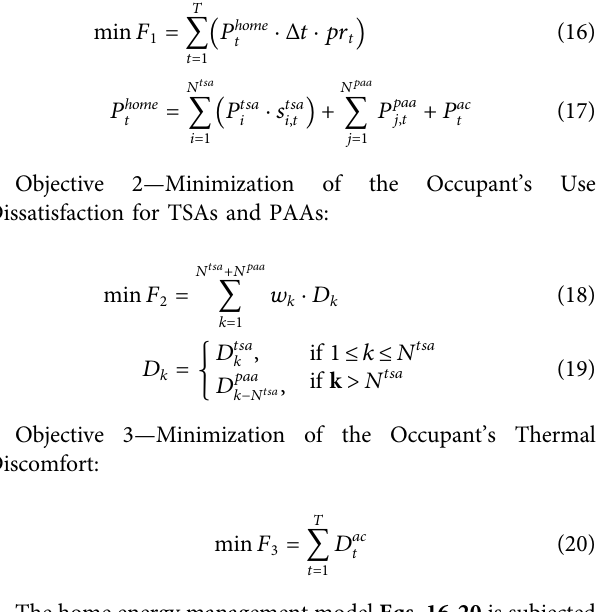
Frontiers in Energy Research |